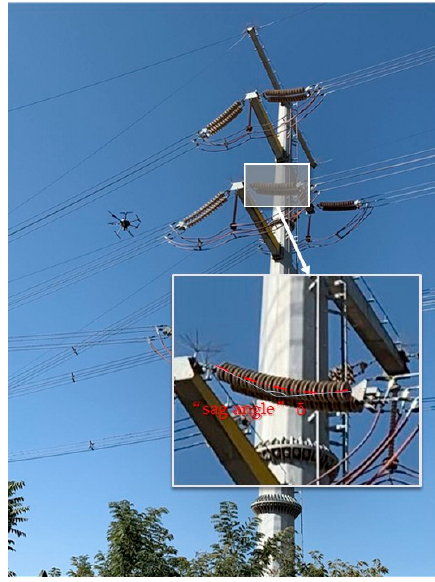
Figure 7. “Sag” phenomenon of insulator string in operation state.